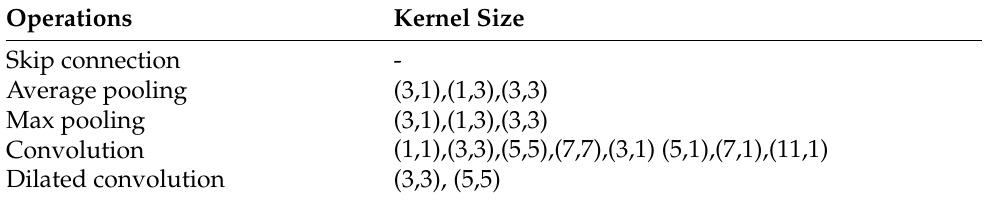
Table 3. Optional operations in search